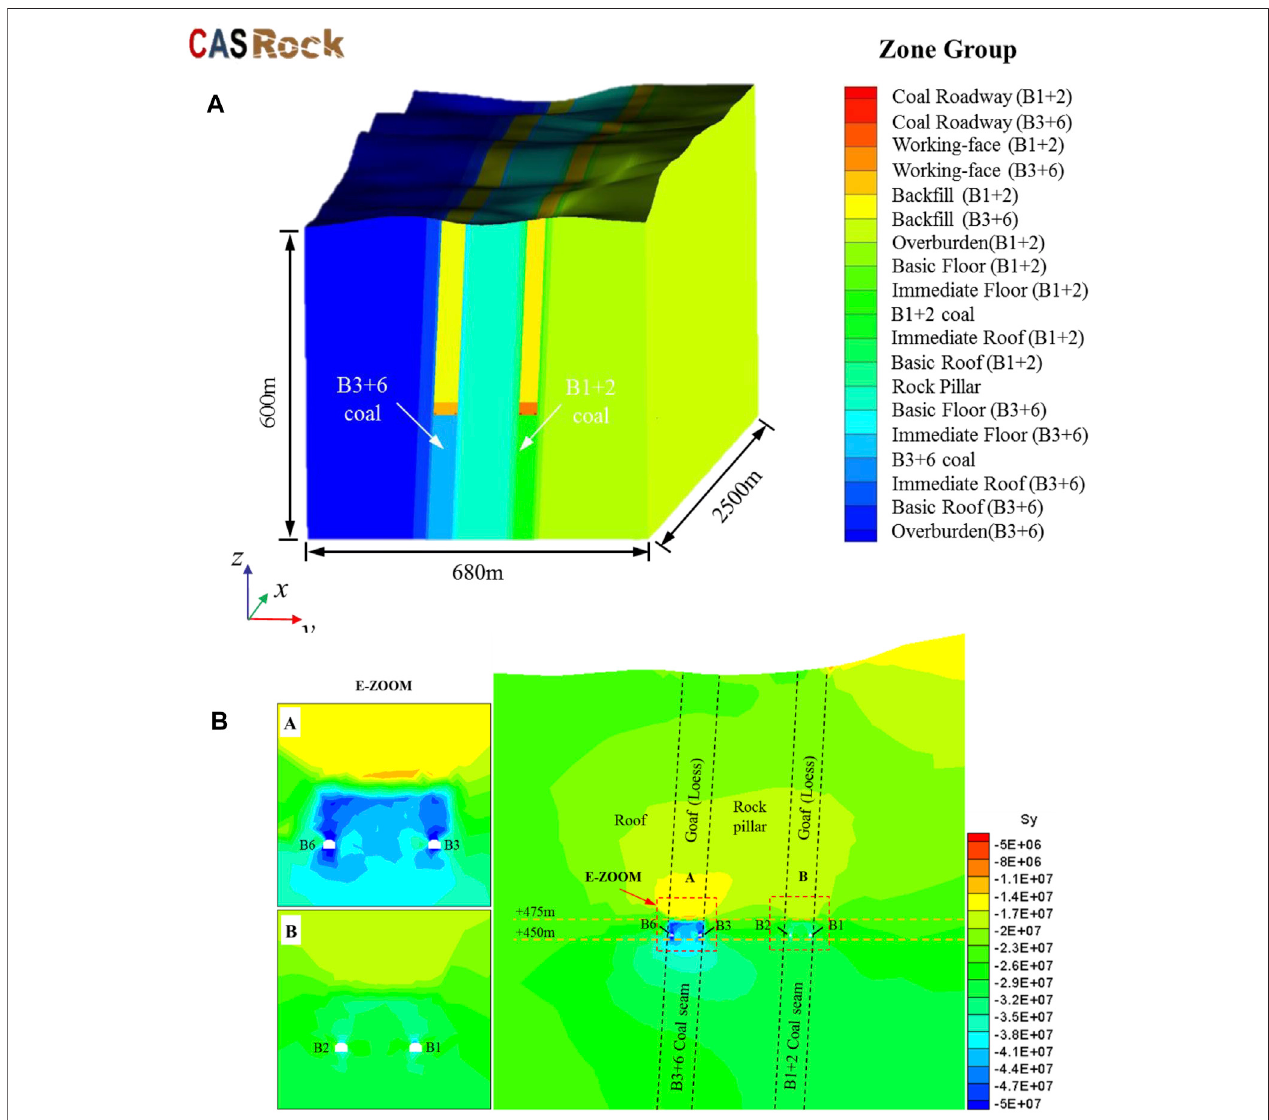
FIGURE9| NumericalsimulationresultsofhorizontalstressdistributioninB3+6coalseam. (A) Numericalcalculationmodel; (B) Horizontalstressdistributionofthe “ 2.1 ” rock burst.